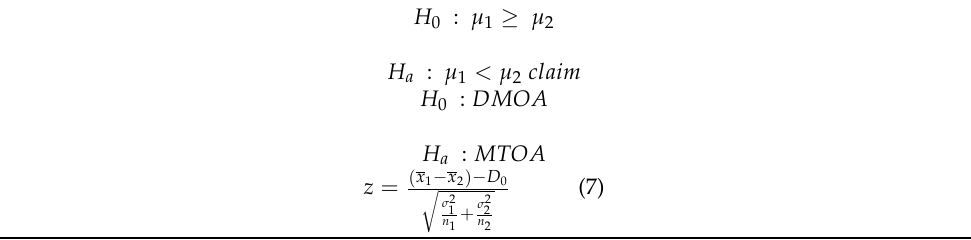
Table 10. Null and Alternative Hypothesis and Z Test Statistics Formula.